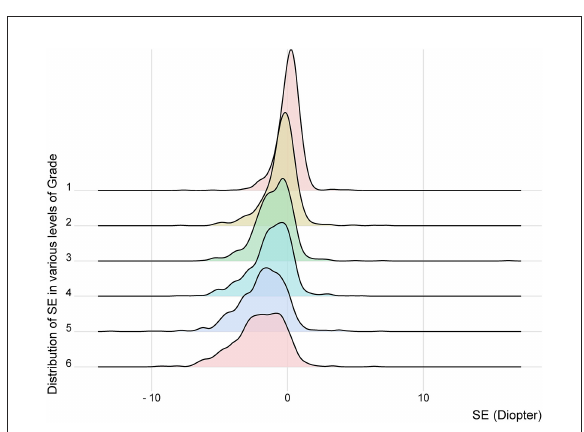
FIGURE3 The distribution of spherical equivalent in various levels of grade. SE, spherical equivalent.